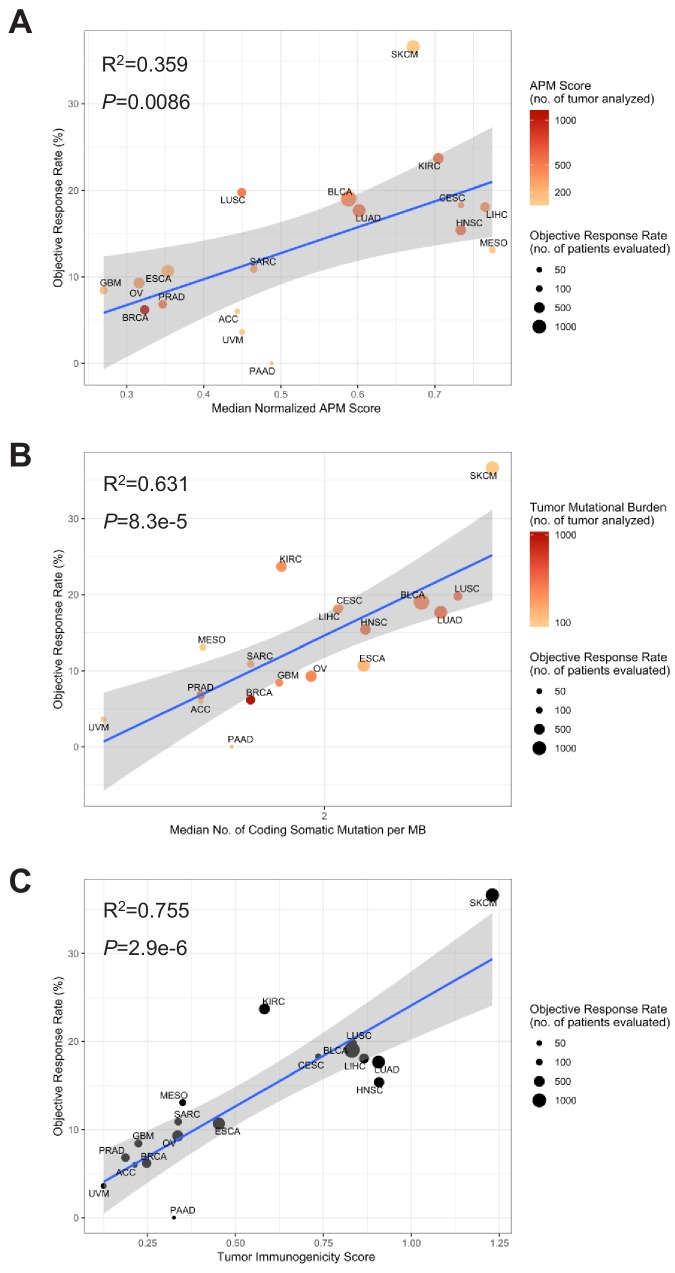
TIGS and predicted pan-cancer response rates to PD-1 inhibition.Correlation between (A) APS, (B) TMB, (C) TIGS and objective response rate (ORR) with anti-PD-1 or anti-PD-L1 therapy in 18 cancer types. Shown are median normalized APS, median number of TMB (non-synonymous mutation/MB) in log scale and TIGS in 18 TCGA tumor types. The number of patients who were evaluated for the objective response rate is shown for each tumor type (size of the circle), along with the number of tumor samples that were analyzed to calculate the APS, TMB or TIGS (degree of shading of the circle). This analysis is similar to main Figure 4, except that APS, TMB and TIGA are all calculated for TCGA datasets.